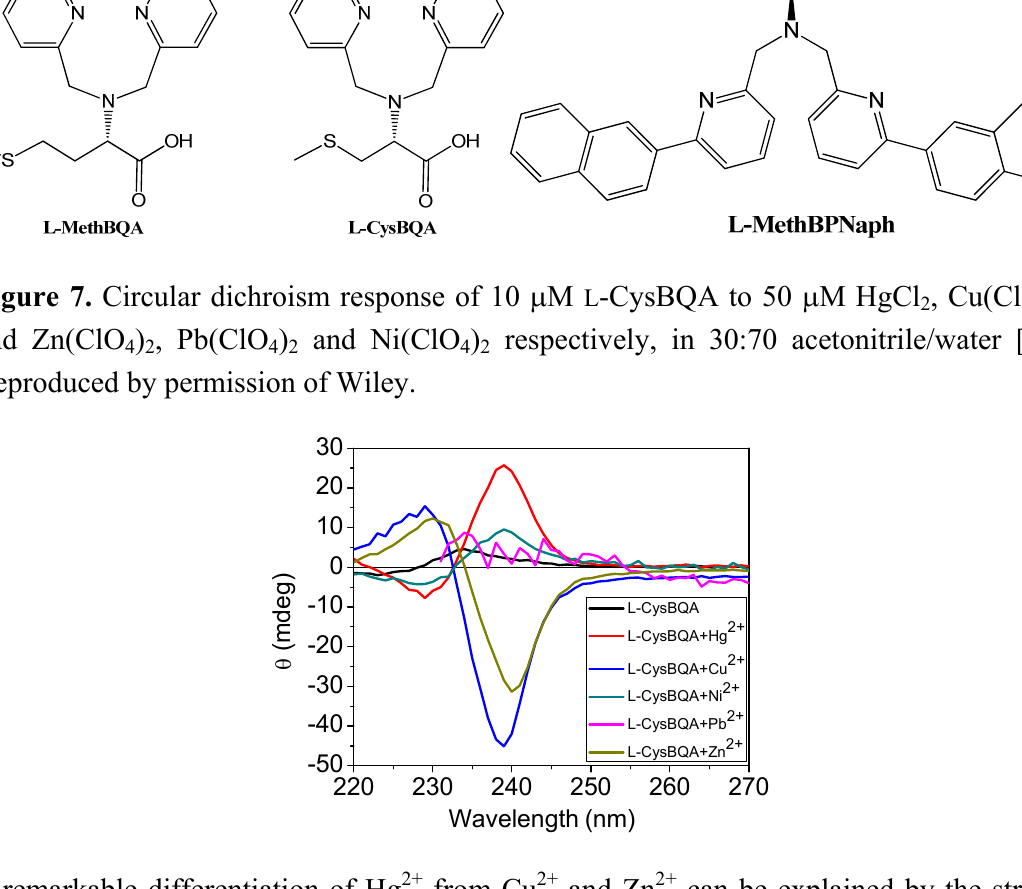
Figure 6. Structures of L -MethBQA, L -CysBQA and a recently synthesized analog L-MethBPNaph.